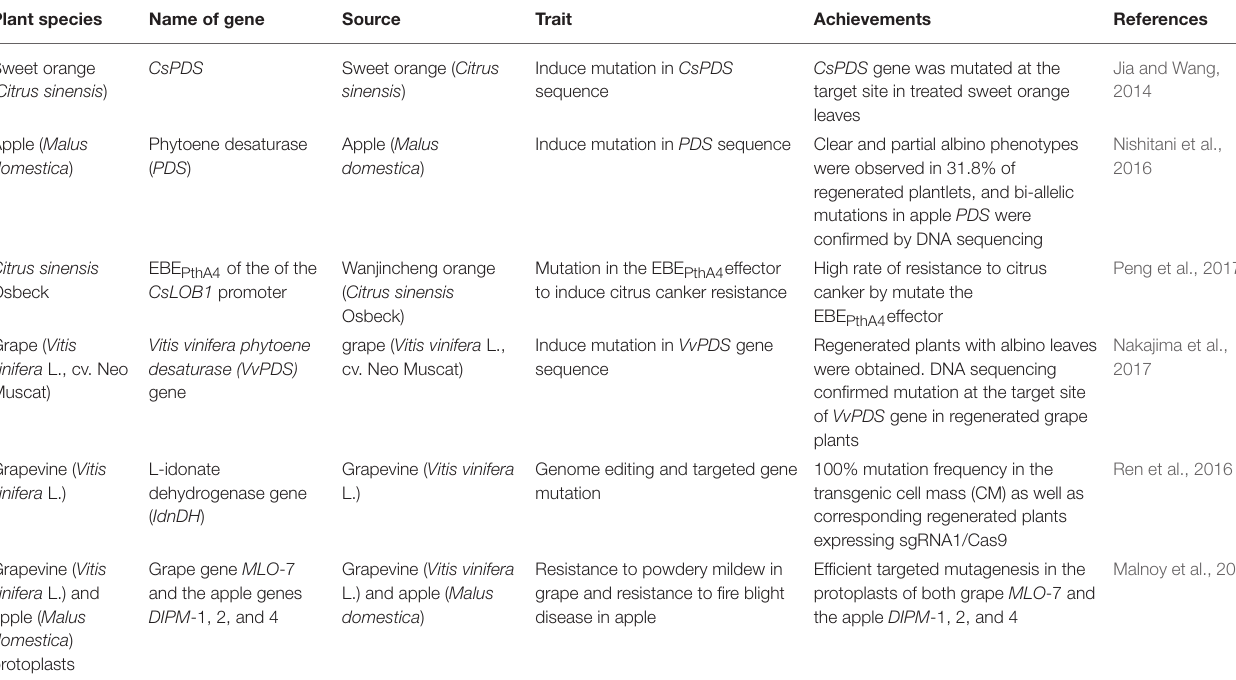
TABLE 4 | Applications of CRISPR/Cas9 in woody fruit species. Plant